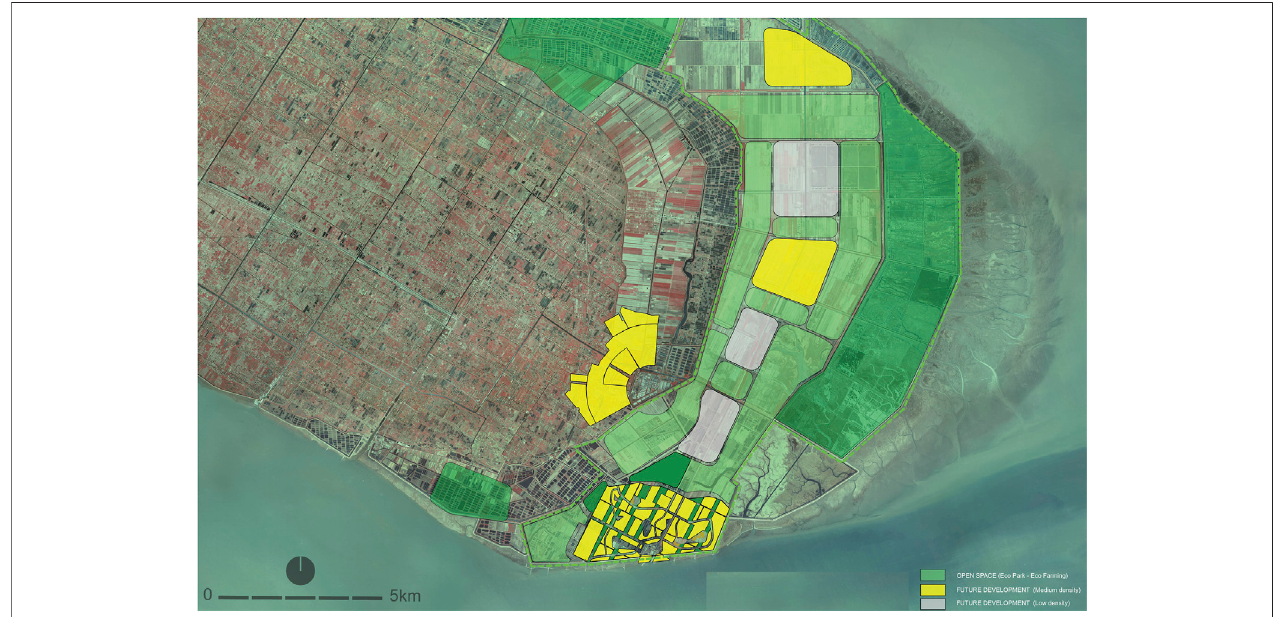
FIGURE 12 | Master plan for Dongtan Eco-city, good for 500,000 inhabitants. The plan has never been realized; resorts with in total more than a thousand speculative (seldom used) luxurious villas and a golf course have been built here instead (Source: Arup,